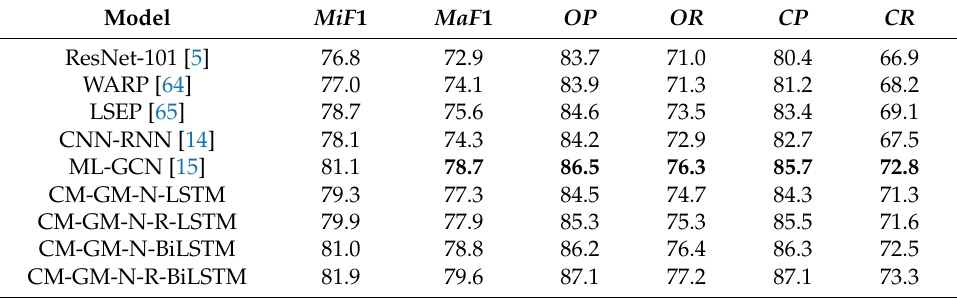
Table 3. The performance of different models on MS-COCO.